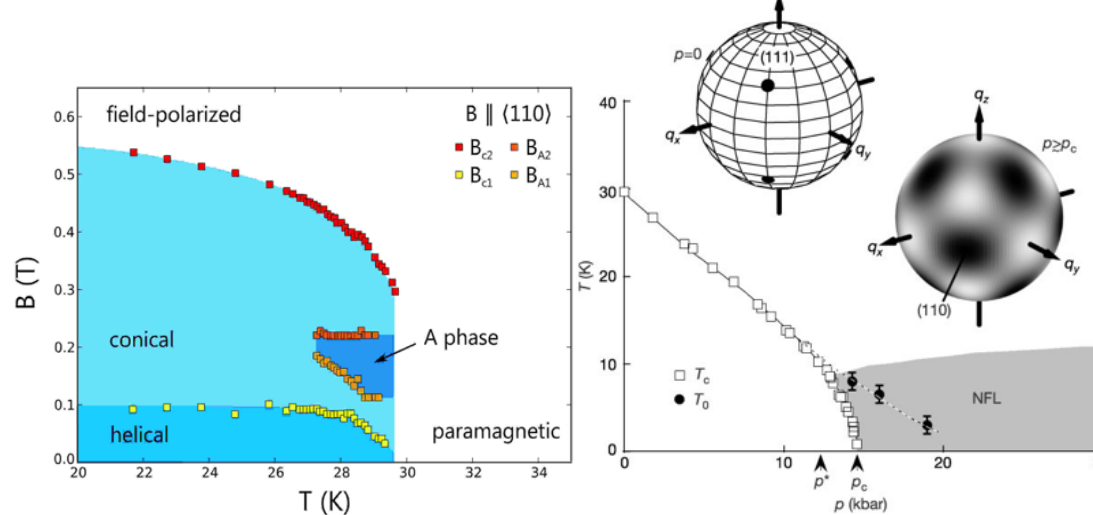
Figure 1. ( Left ) The (B-T)-phase diagram of MnSi. The A-phase contains the skyrmion lattice (reproduced from [1], c (cid:13) by the American Association for the Advancement of Science (AAAS). ( Right ) The (T-P)-phase diagram of MnSi. The grey shaded area designates the non-Fermi-liquid phase (NFL). The spheres show directions of strong elastic neutron intensity in reciprocal space (reproduced from [2], c (cid:13) by Springer